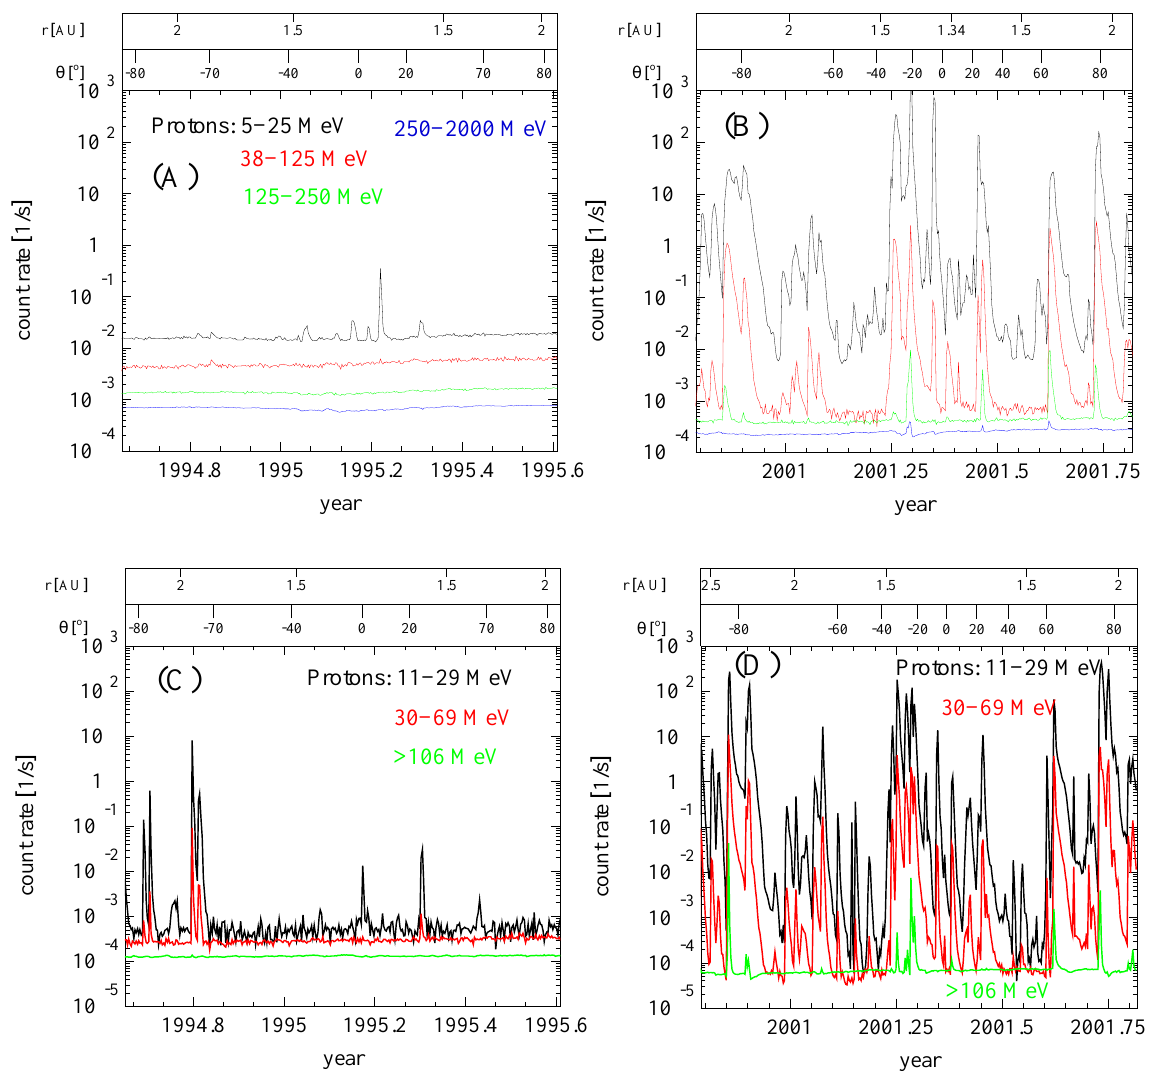
Fig. 5. Daily averaged count rates of different Ulysses/KET proton channels in the energy range from 5 to 2000 MeV during the first (A) and second (B) fast latitude scan. The lower two panels (C) and (D) display the corresponding proton measurements in the energy range from 11 MeV to > 106 MeV at Earth by the University of Chicago’s instrument on board IMP